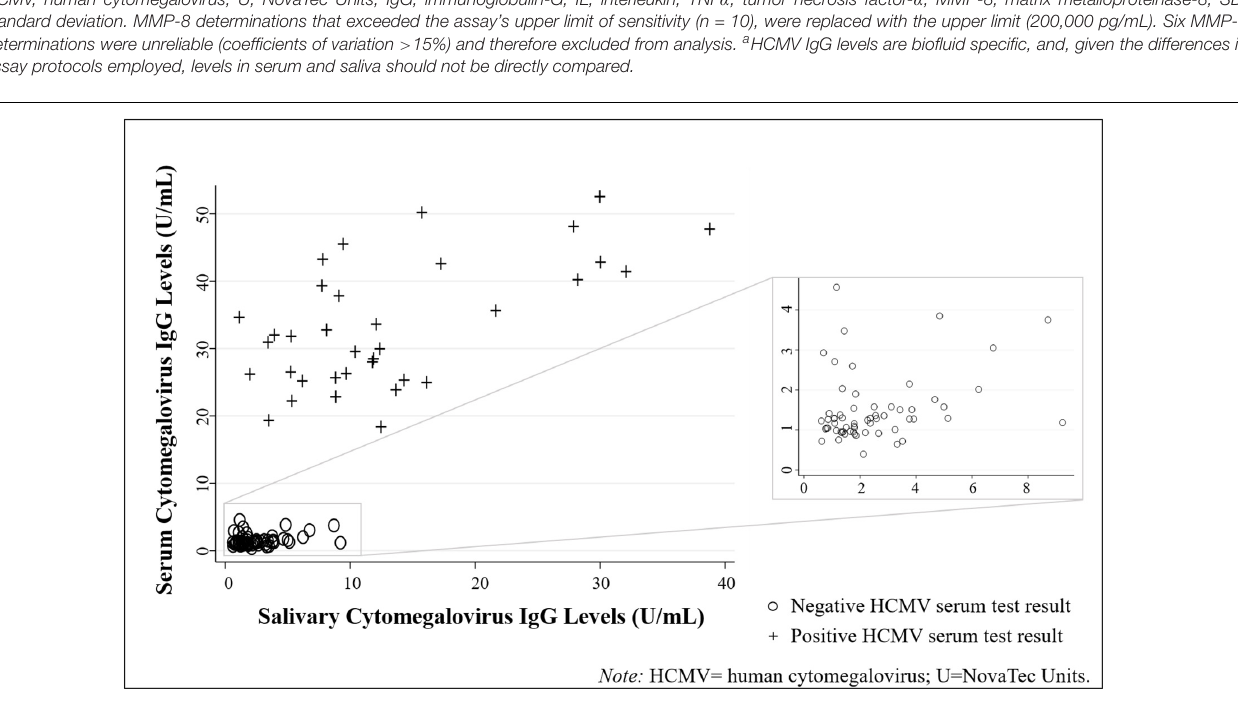
Race (white vs. African American) was tested as a covariate in all regression models presented above (subsampled for white